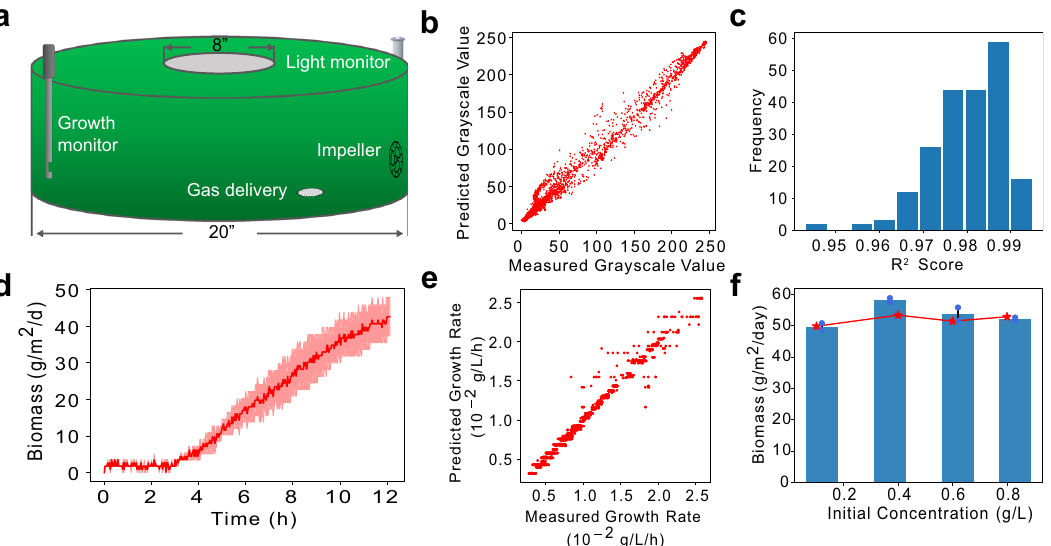
Fig. 6 Scaling-up of SAC with a pond system. The pond system design is shown in a . b and c show the prediction evaluation of the adapted LDPM for the pond system. The LDPM achieved an overall R 2 score of 0.986 ( b ) and pixel-by-pixel analysis suggested that prediction at all pixels were reasonably good, with a minimal R 2 score of 0.943 ( c ). d , biomass production with the outdoor pond system. e, prediction evaluation of the GRM adapted for a pond system. f , machine learning-based growth simulation (red line) suggested that setting the initial cell concentration to around 0.4 g/L achieves optimal biomass productivity under the growth condition mimicking Texas Summer, which was well supported by the measured results (blue bars). Original data points are shown on the plot with blue dots. Error bands represent standard deviations ( n = 2 independent samples). Source data are provided as a Source Data fi score of 0.943 (Fig. 6c). The GRM prediction also achieved an R 2